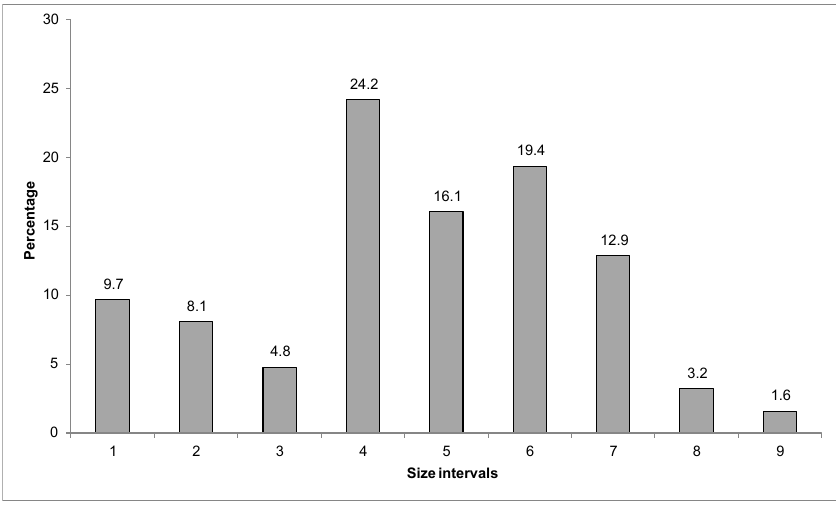
Figure 6 Percentage of the length of gemmae (number of measurements: 62) in